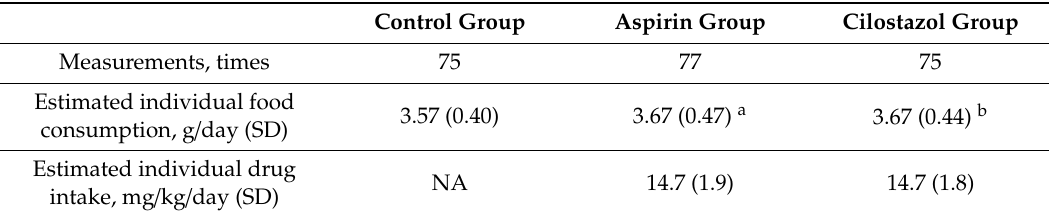
Figure 1. The flow diagram of study schedule and grouping. Table 1. Estimated individual feed consumption and drug intake (per mouse) of the three groups.